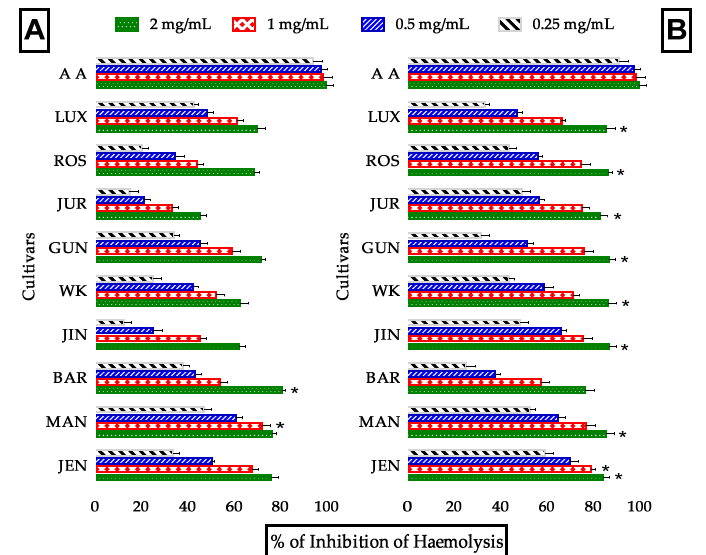
Figure 7. Antihaemolytic activity of lupin flours in unprocessed and processed conditions. Anti- haemolytic property of unprocessed (A) and processed (B) lupin flours; nine cultivars of lupin flours vs. ascorbic acid (standard). Data were presented as mean ± SEM of three replicates; (* Significance at p < 0.05 vs. standard: ascorbic